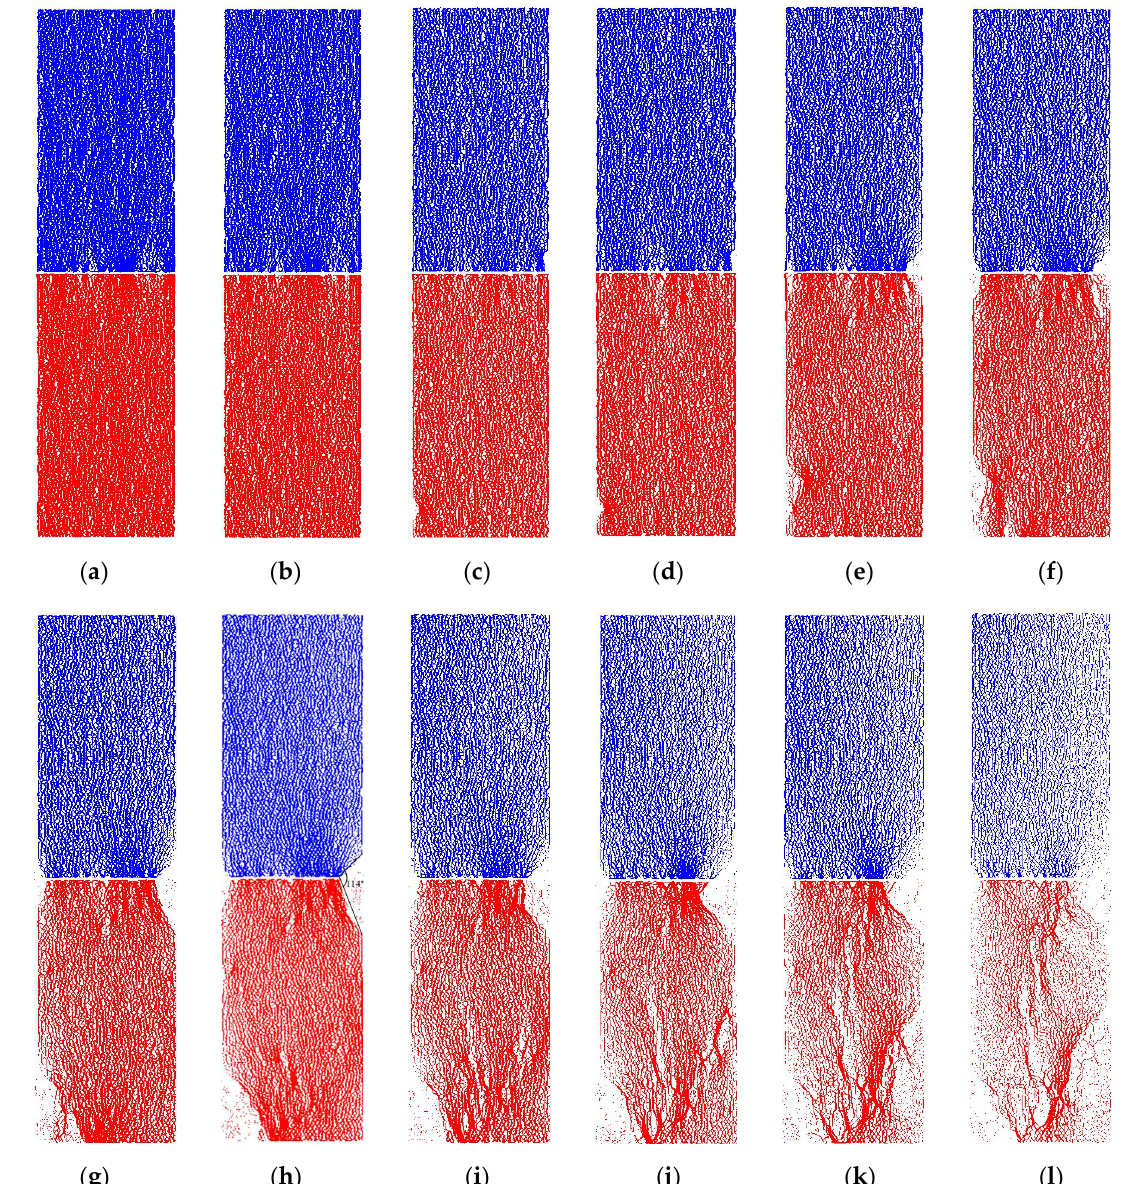
Figure 12. Evolution of contact-force chain serial coal pillar specimens. ( a ) 0; ( b ) 15,000; ( c ) 18,000; ( d ) 20,400; ( e ) 20,800; ( f ) 21,200; ( g ) 21,600; ( h ) 22,000; ( i ) 22,400; ( j ) 22,800; ( k ) 23,200; ( l ) 23,487. Note: The denoted le(cid:308)ers shown in the figure was corresponding to those on the stress-time curve in Fig- ure 11.